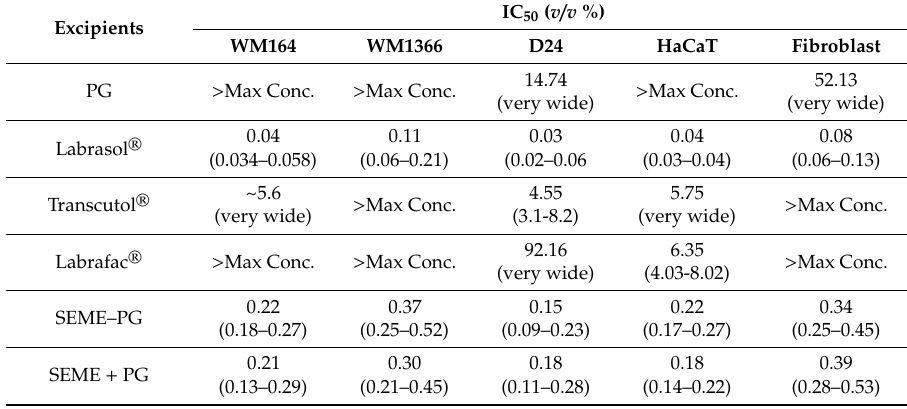
Table 1. IC 50 values of excipients in the tested cells. IC 50 values on WM164, WM1366, D24, and HaCaT cell lines after 60 min of incubation. All values are expressed in mean concentration of excipients ( v / v %) with 95% confidence interval indicated in brackets ( n = 5). IC 50 values above 100% v / v (%) were considered as not converged. ( > Max Conc.; not reaching the sensitive range for the applied